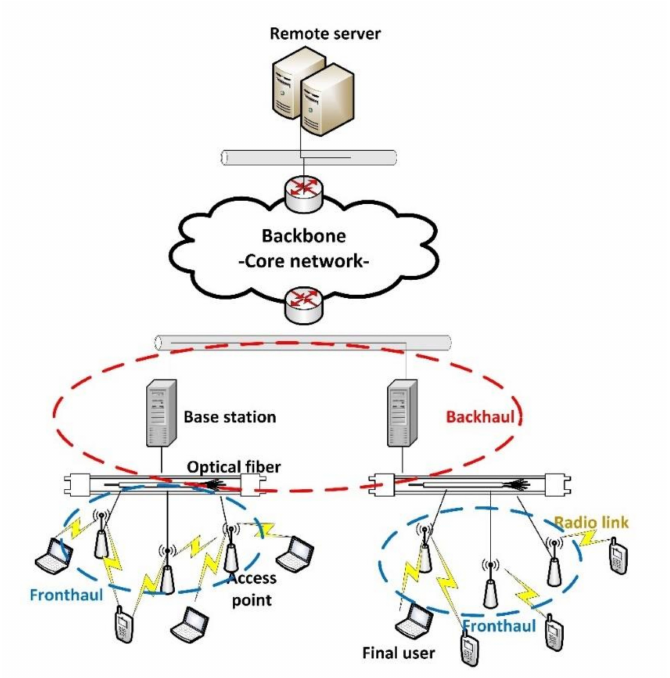
Figure 1. Scheme of C-RAN architectures in future 5G